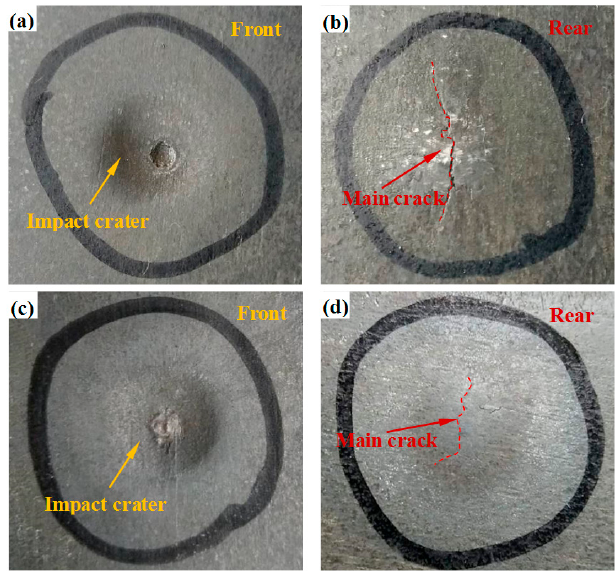
Figure 9. Views of damage patterns on the front face and rear face of target plates after projectile penetration. ( a ) Front view and ( b ) rear view of the hot-rolled titanium alloy plate. ( c ) Front view and ( d ) rear view of the heat-treated titanium alloy plate.